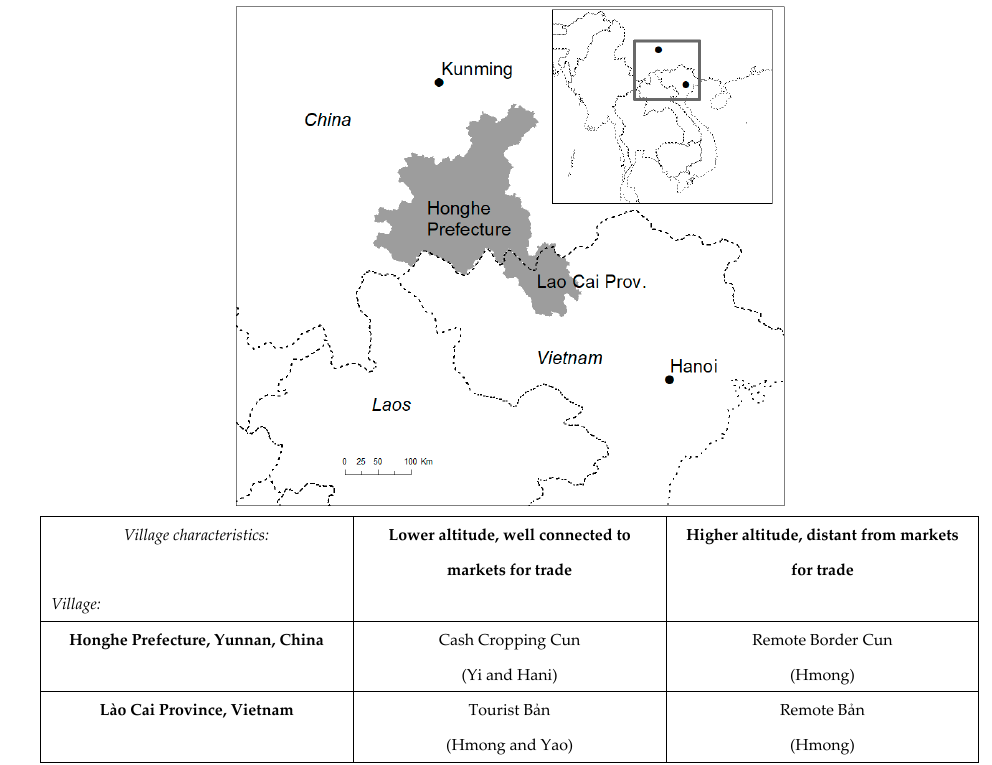
Figure 1. Locations and main characteristics of our four case-study locations.